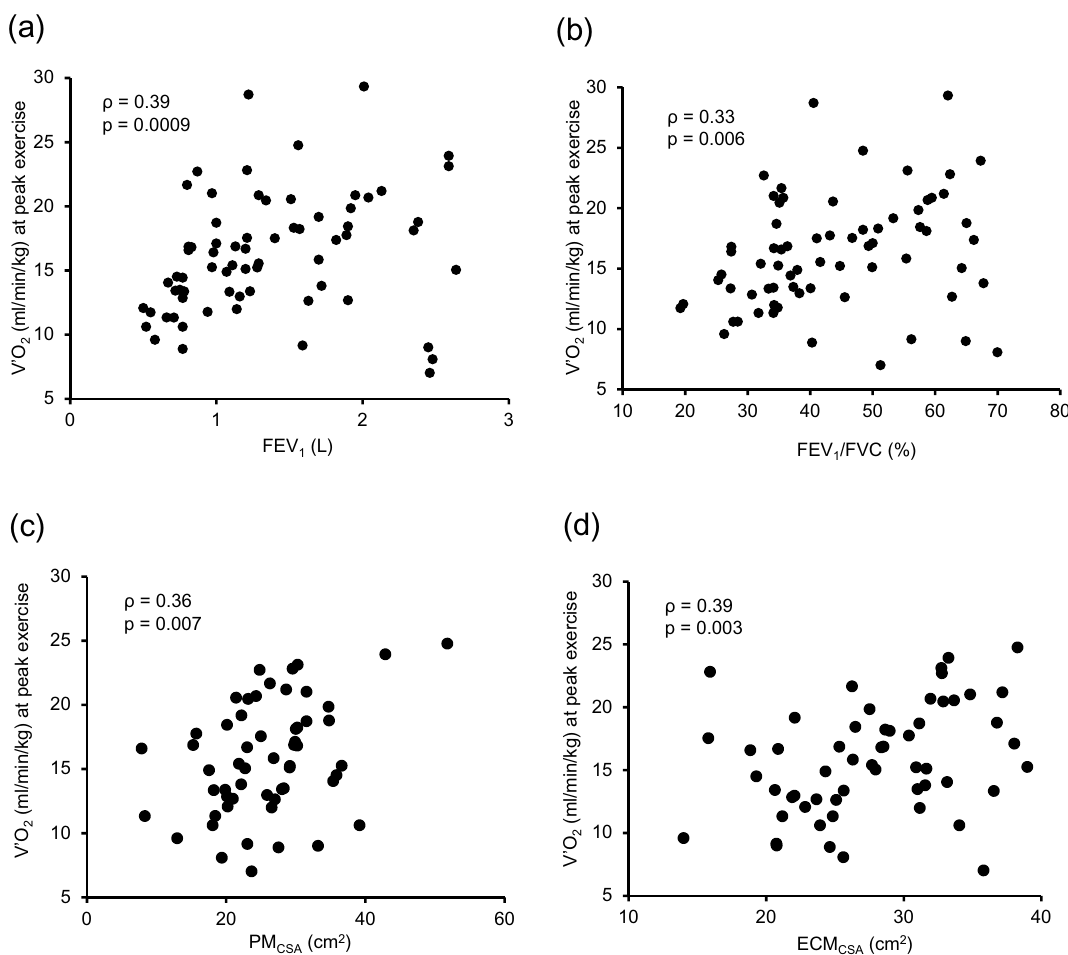
˙ VO Figure 1. Correlations between 2 at peak exercise and clinical parameters of COPD. Correlations between ˙ VO ˙ VO 2 oxygen uptake, COPD 2 at peak exercise and ( a ) FEV 1 , ( b ) FEV 1 /FEV, ( c ) PM CSA , and ( d ) ECM CSA . chronic obstructive pulmonary disease, FEV 1 forced expiratory volume in 1 s, FVC forced vital capacity, PM CSA cross-sectional area of the pectoralis muscles, ECM CSA cross-sectional area of the erector spinae muscles.